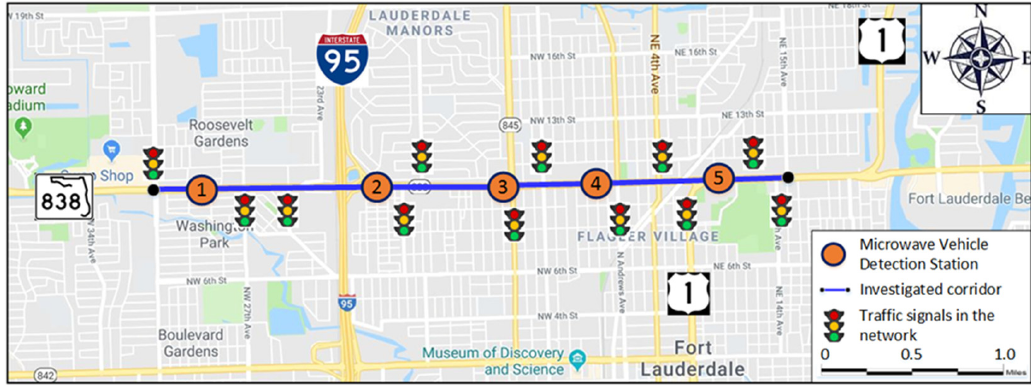
Figure 2. Study area.